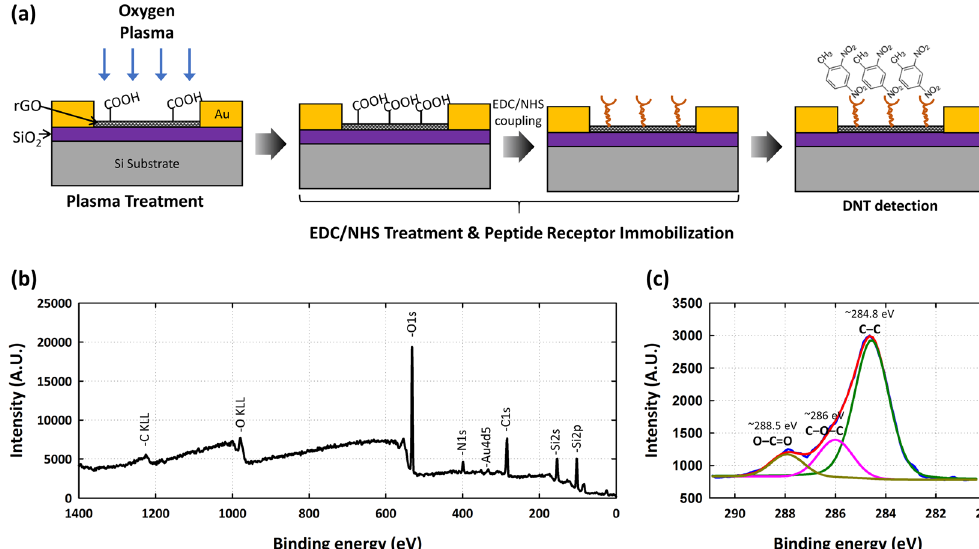
Figure 2. Surface functionalization of the rGO sensor: ( a ) Schematic illustration of the DNT binding peptide receptor functionalization process. ( b ) Wide-range scan XPS results of DNT-bp on the rGO sensor. ( c ) C1s region (narrow range scan) XPS results showing the resolved 284.8 eV (C-C, graphitic group), 286 eV (C-O-C, ether group) and 288.5 eV (O-C = O, carboxylic acid group) peaks, respectively.